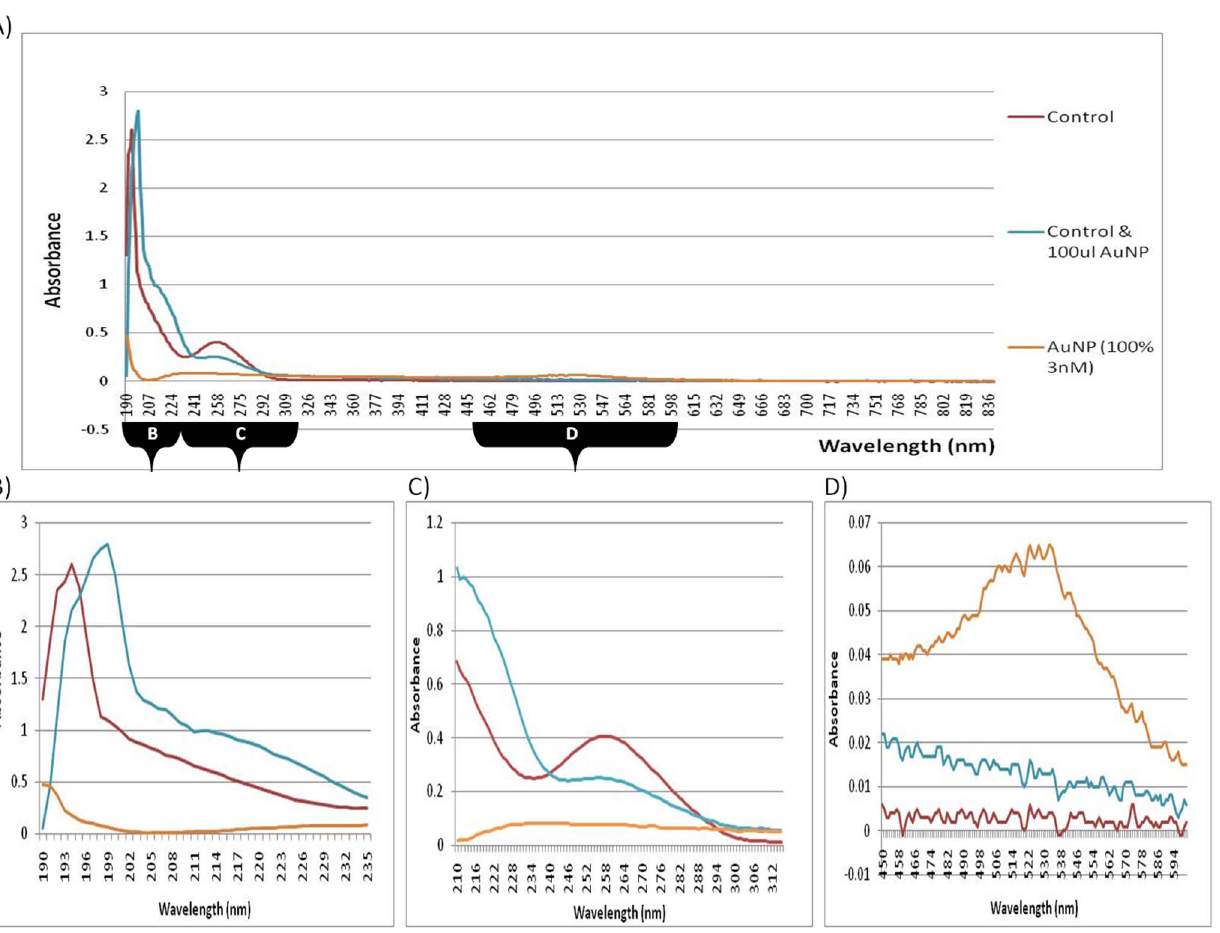
Figure 2. UV-Vis spectroscopy of RNA from co-isolation spiked samples. ( A ) Full spectrum absorbance of artificial AuNP-spikes, measured at wavelengths from 190–840 nm. ( B ) Peak shifts of absorption spectrums of artificial AuNP-spikes, measured at wavelengths from 190–235 nm. ( C ) Traditional absorbance spectrum of artificial AuNP-spikes, measured at wavelengths from 220–340 nm. ( D ) Absorption spectrums of artificial AuNP-spikes, measured at wavelengths from 450–600